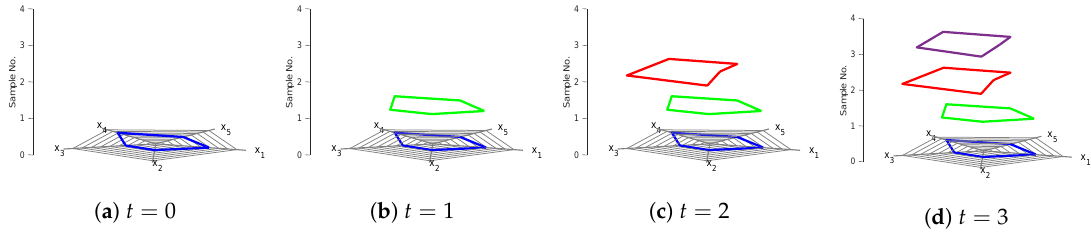
Figure 2. Representing multi-dimensional time series data using Kiviat diagrams. The same five-dimensional dataset as in Figure 1, with one-minute sampling time, is used for illustration purposes. The first sample is plotted ( a ) on the Kiviat plot having a time axis that is normal to the plot plane. The next samples are added as additional Kiviat plots whose planes are parallel to the plane of the first and spaced along the time axis according to the sampling time ( b – d ). The diagram can be updated by adding such “data slices” in a first-in, first-out